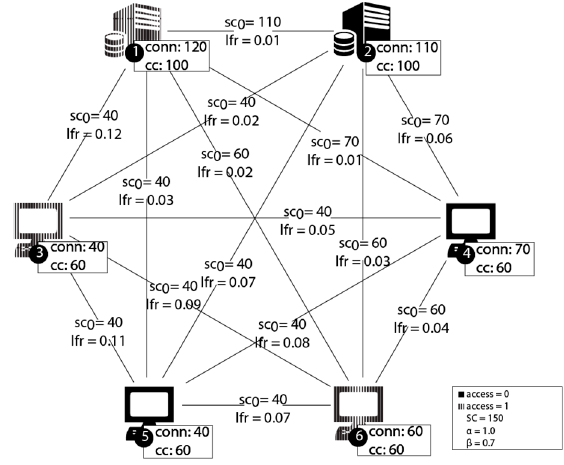
Figure 6. Network at initial state.